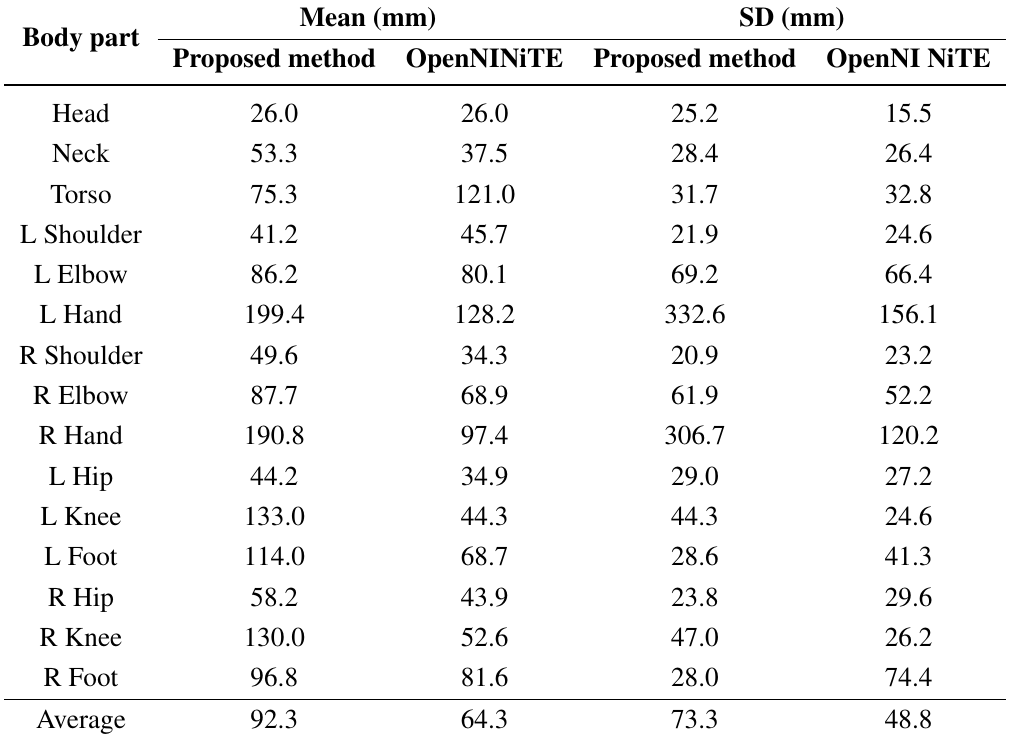
Table 2. Experimental results of pose estimation. L, left; R,